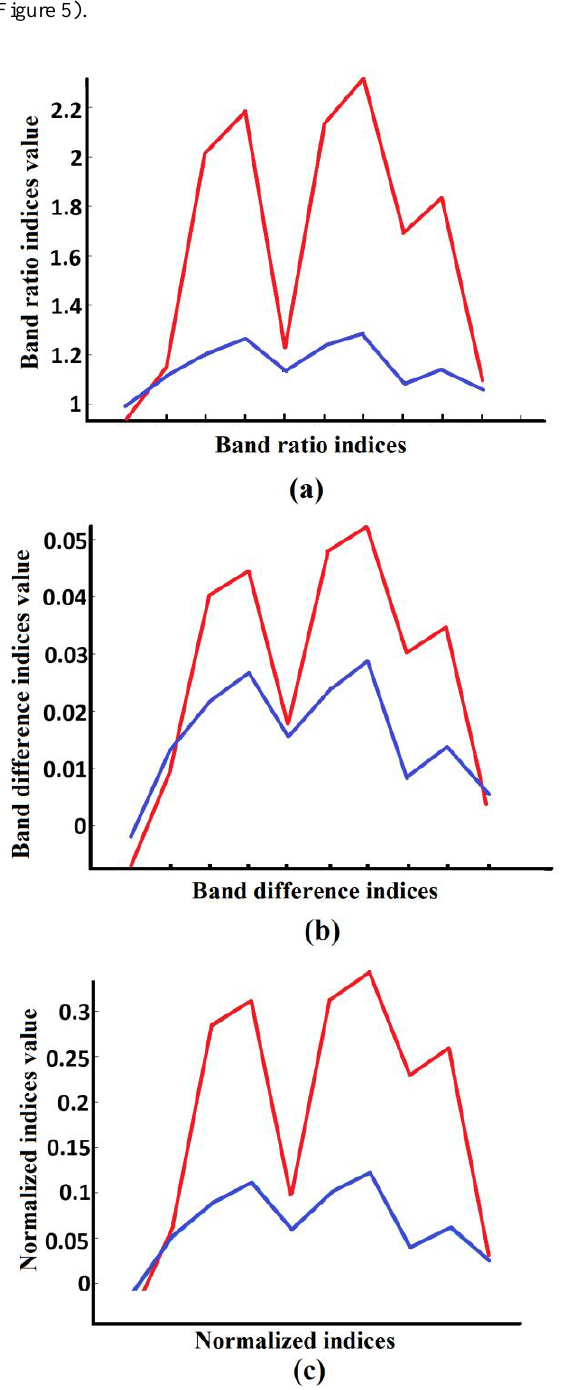
Figure 5. Spectral band ratio (a), difference (b) and normalized (c) indices generated using the average reflectance of two selected patches. The red graph is related to blooming condition and the blue one is related to the non-blooming condition Using numerical comparison, spectral features which the red tide Figure 4. The Spectral response of the two selected patches. The red phenomenon causes a noticeable change in their value have been graph represents the spectral response during the occurrence of HAB extracted. The ideal thresholds of the extracted indices have been while the blue one shows the spectral response in non-blooming determined using ROC curves. Table 2, represents the extracted condition indices and their corresponding ideal The difference in the spectral response of these patches during the presence of the phenomenon comparing with the normal